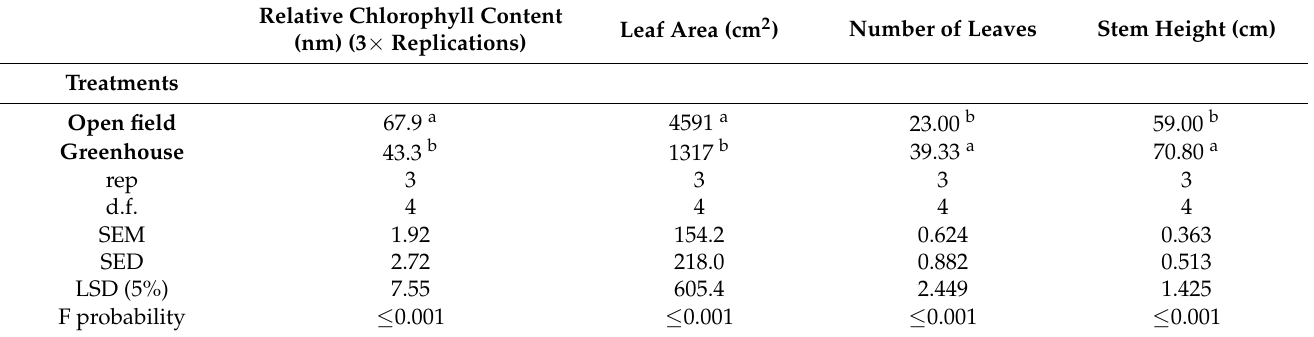
Table 1. Comparison of agronomic parameters of A . Graecizans L. grown in open field vs. greenhouse. Relative Chlorophyll Content